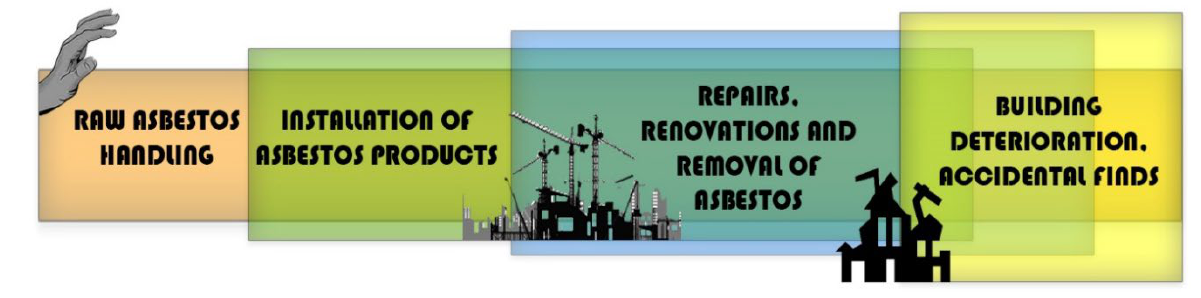
Figure 2. The four waves of asbestos exposure (figure based on Landrigan, 1991 [55]) and reproduced from Wallis et al., 2020 [54]).